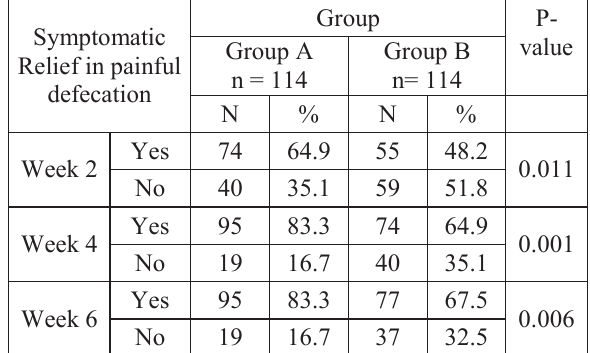
Table-2: Symptomatic relief in painful defecation observed at three follow up times in both